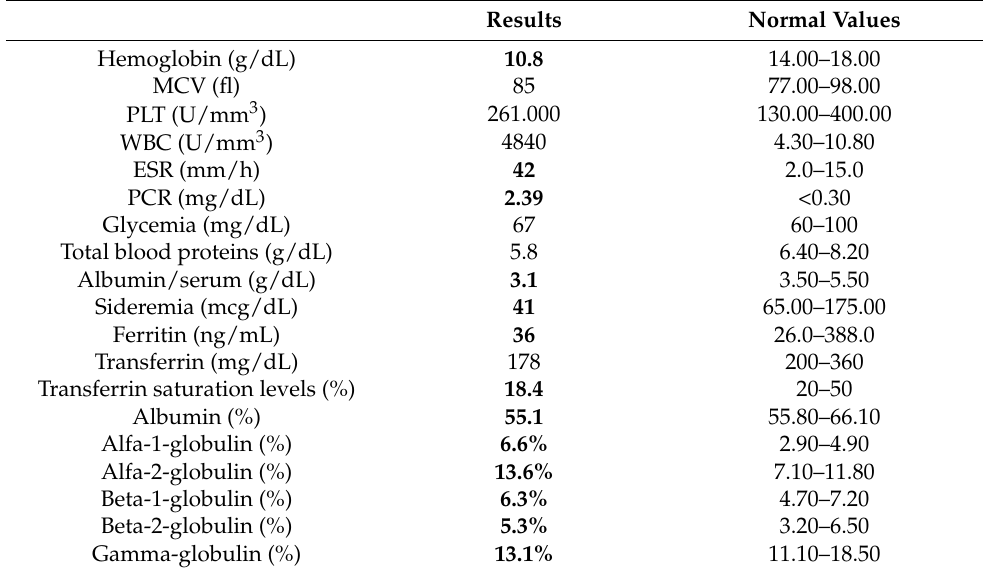
Table 1. Results of main laboratory examinations performed; altered values in bold. (Abbrevi- ations: MCV = mean corpuscular volume; PLT = platelet count; WBC = white blood cell count; ESR = erythrocyte sedimentation rate; PCR = polymerase chain